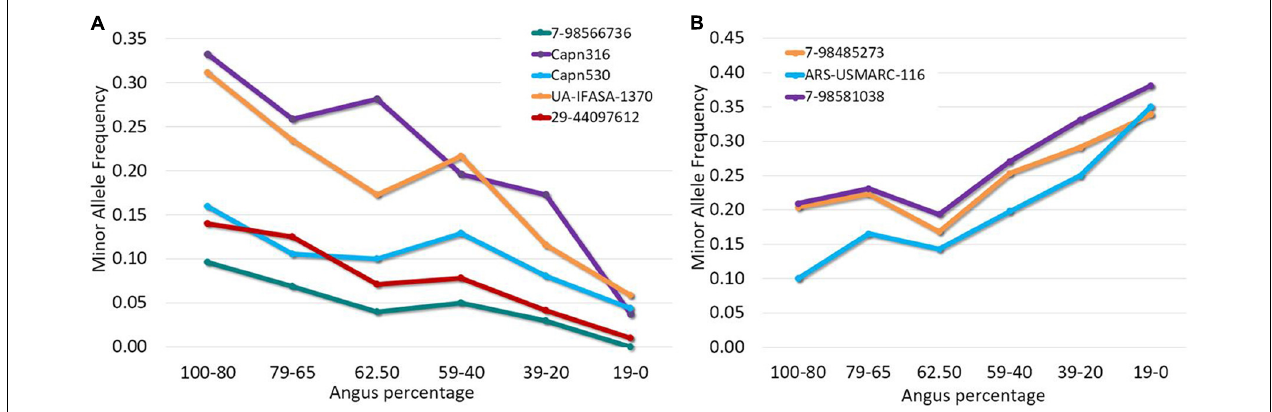
FIGURE 1 | Minor allele frequency for selected µ -calpain and calpastatin SNPs across six breed groups present in an Angus-Brahman crossbred population. (A) Contains SNPs whose MAF decreases when Angus percentage decreases; (B) includes SNPs whose MAF increases when Angus percentage decreases.